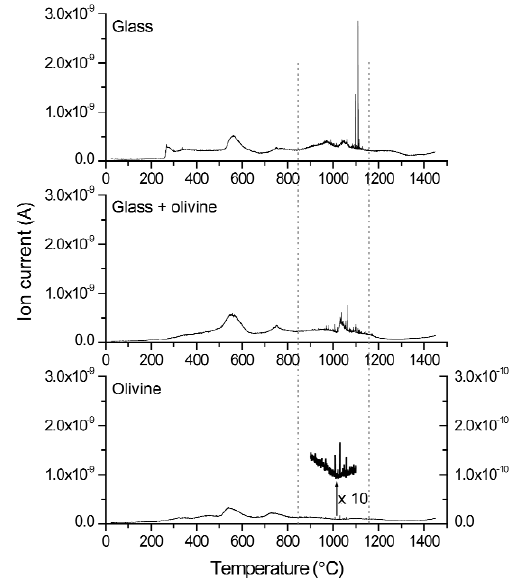
Fig. 13. CO 2 release curves from black sand sam- ples. A – vitreous matrix with olivine crystals; B – vitreous matrix without olivine crystals; C – olivine crystals, separated from the vitreous matrix.